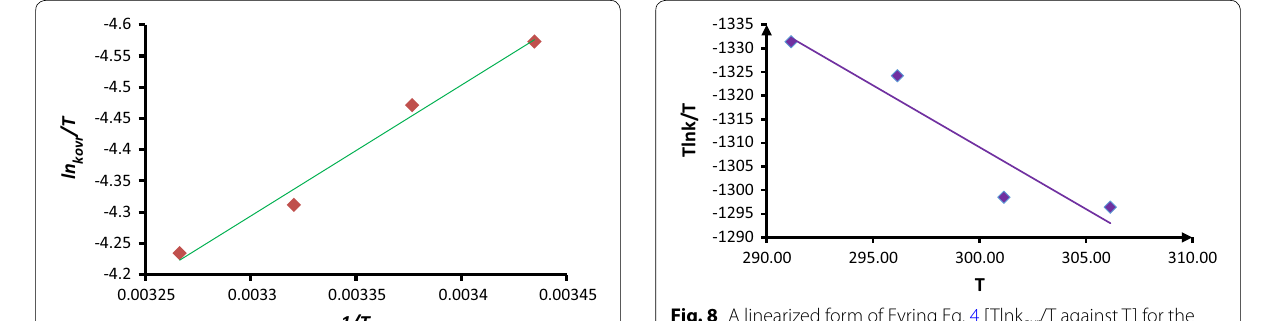
Table 2 Activation parameters (∆S ‡ , ∆H ‡ , ∆G ‡ and ln A) at 18 °C for the reaction between (1), (2) and N–H compounds